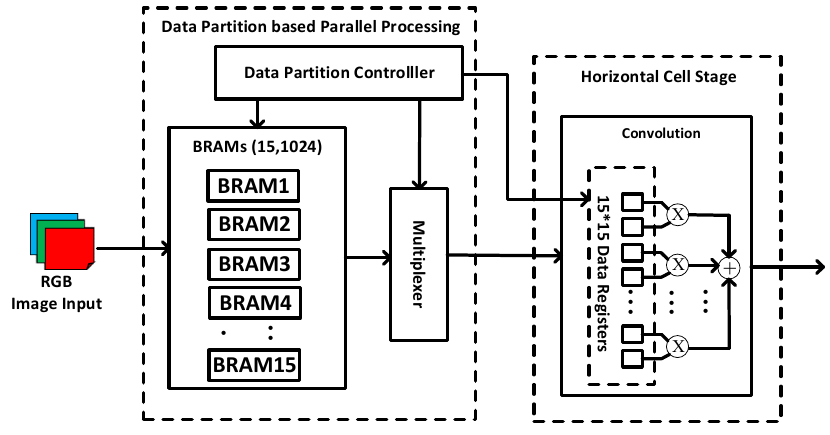
Figure 3. Data partition-based parallel processing with S-shape sliding.